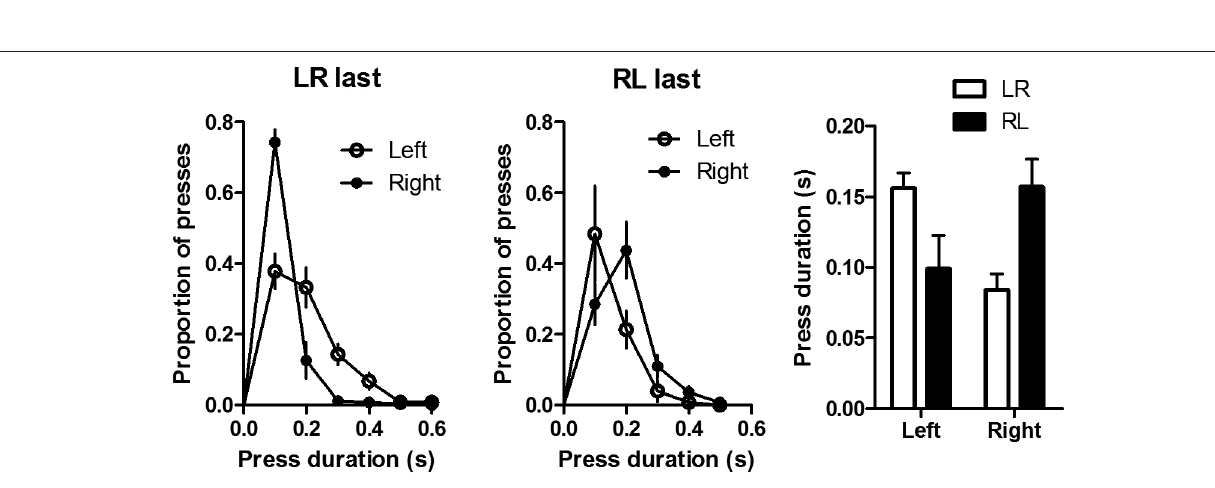
FIgure 0 | Sequence acquisition and reversal in naïve mice without previous temporal differentiation training. Lever press duration distributions of the first and second actions on the last day of training for left-right sequence (LR) and for right-left sequence (RL). Also shown is the mean of the median press duration of the two actions for LR and RL sequences.